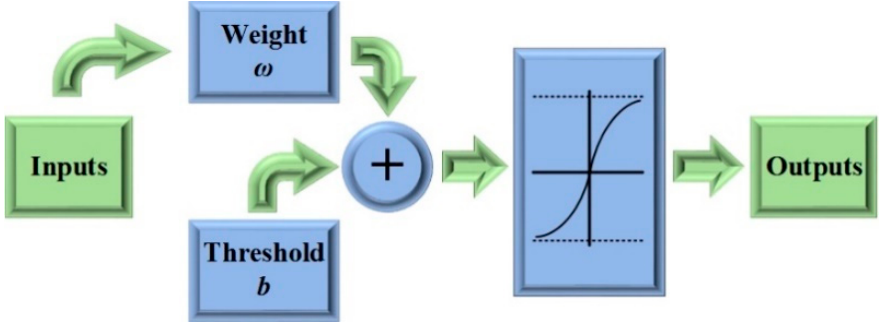
Figure 12. The architecture of the linear neural network.